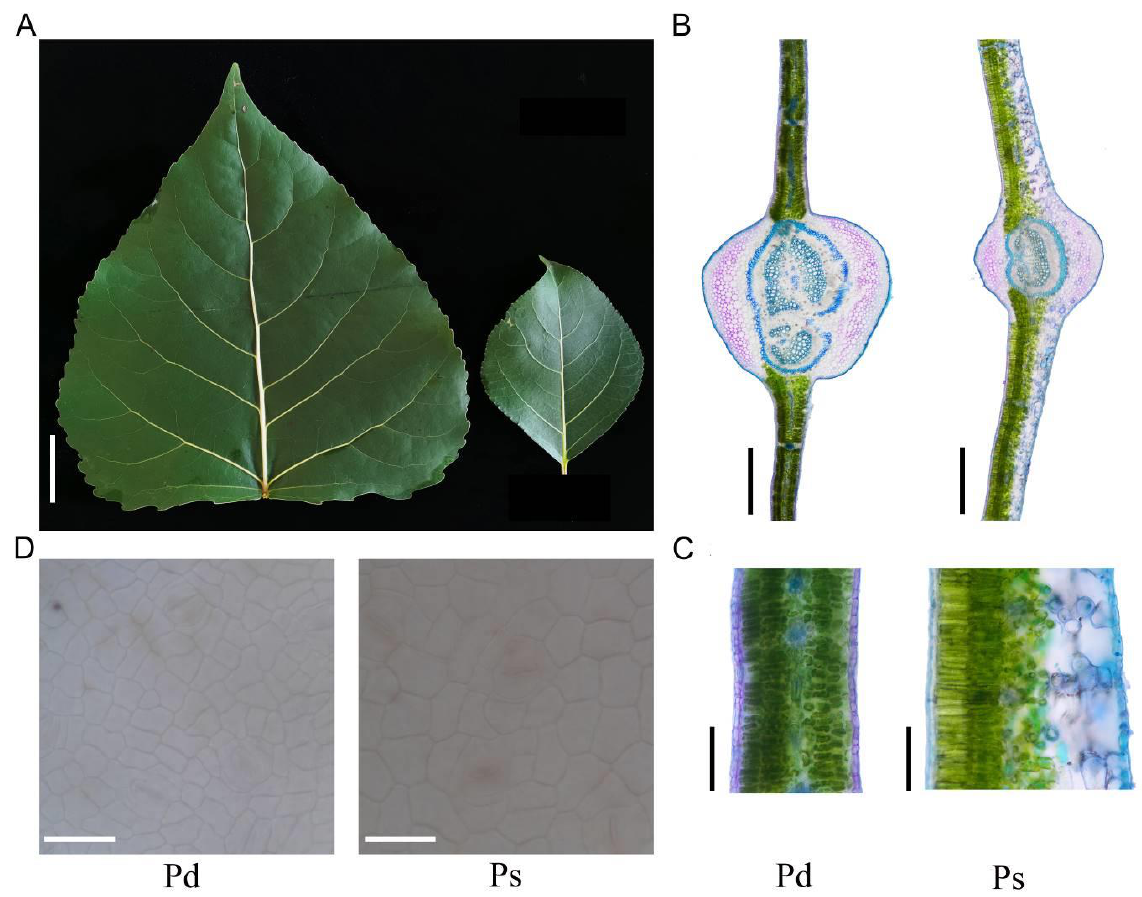
Figure 1. Leaf characteristics of P . deltoides ‘Danhong’ and P. simonii ‘Tongliao1’. ( A ) Morphology of mature leaves. ( B , C ) The anatomical structure of leaf cross section. ( D ) Photograph of epidermal cells. Bar = 3 cm ( A ), 500 µ m ( B ), 100 µ m ( C ), and 50 µ m ( D ). Pd, P . deltoides ‘Danhong’; Ps, P. simonii ‘Tongliao 1 ’ . Table 1. Phenotypic character of P. deltoides ‘Danhong’ and P. simonii ‘Tongliao 1 ’ .